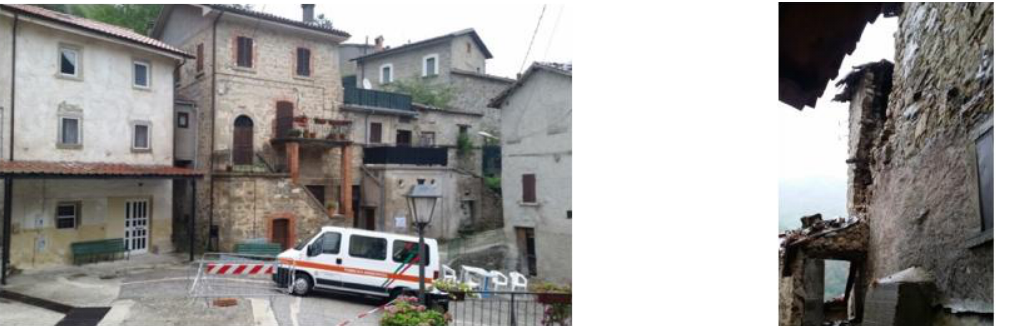
Figure 4 : a) Undamaged buildings in the main square of Vezzano village and b) Partial collapse of an abandoned build-